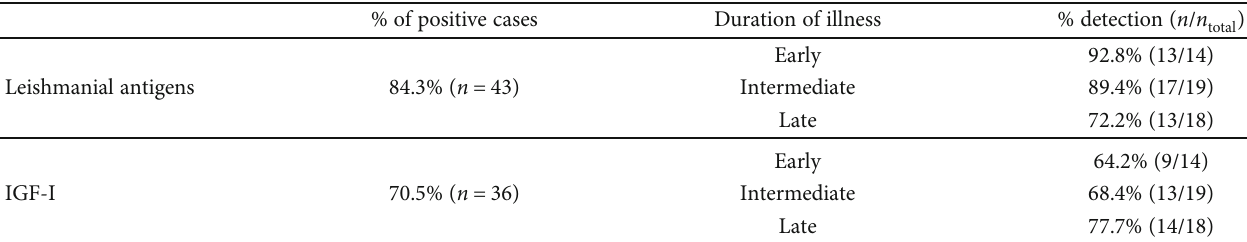
Table 1: Insulin-like growth factor (IGF)-I or Leishmania antigen detection in lesions of cutaneous leishmaniases patients according to the duration of illness.